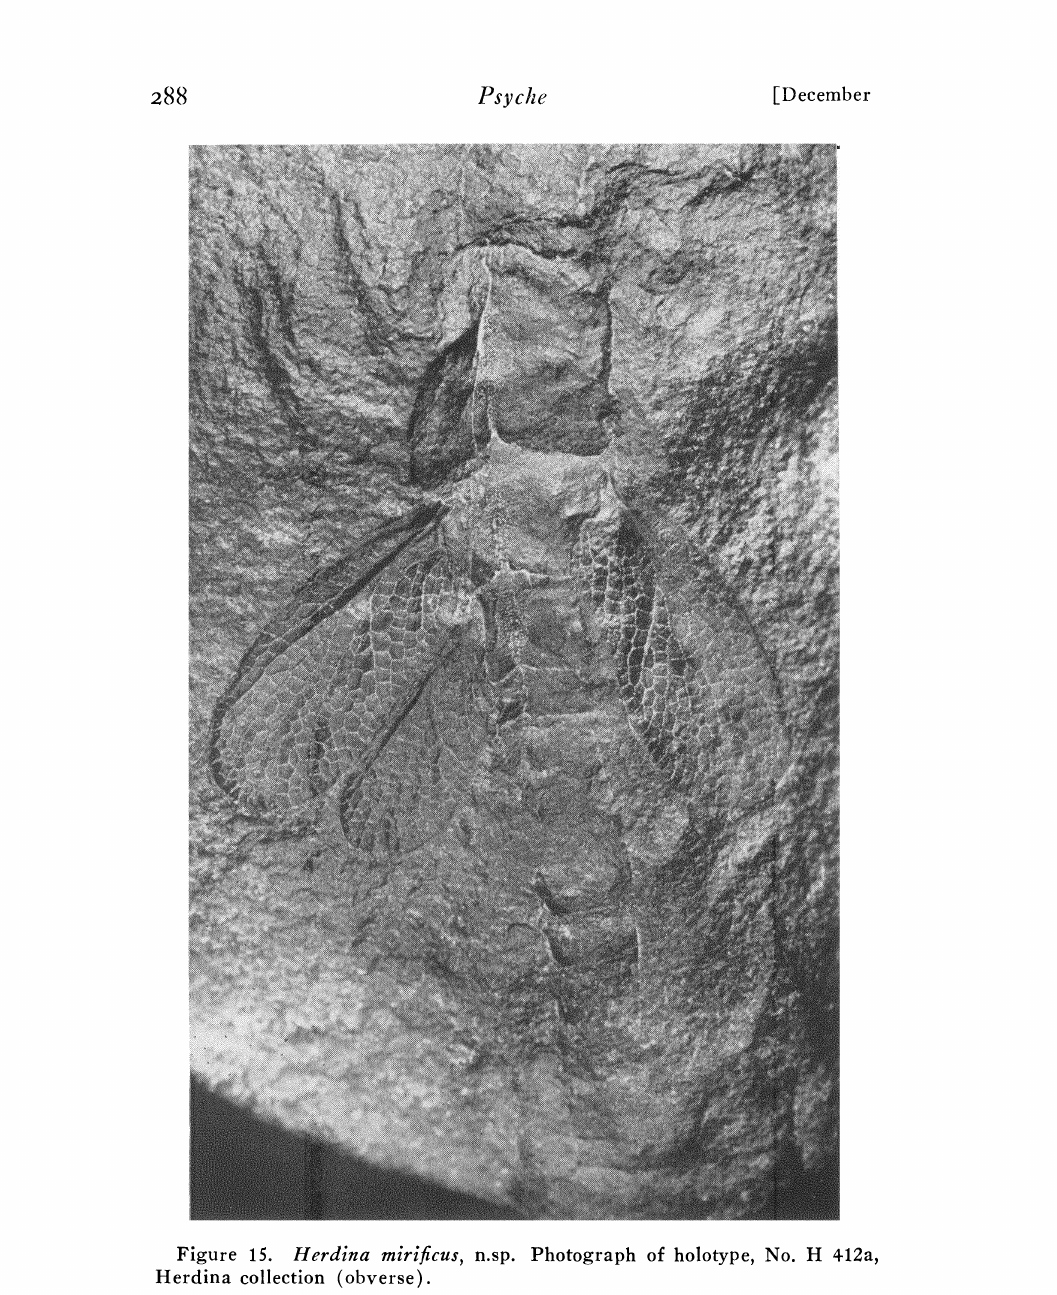
Figure 15. Herdina mirificus, n.sp. Photograph of holotype, No. H 412a, Herdina collection